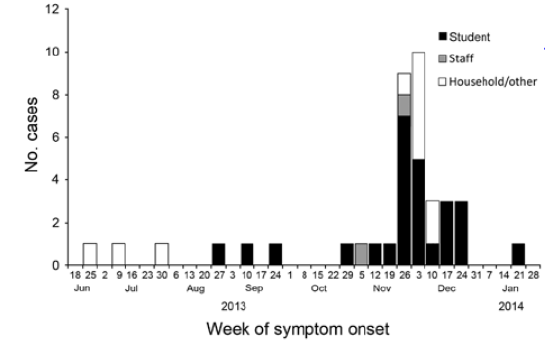
Figure 11 . Week of Symptom Onset Epidemic Curve from Florida Case